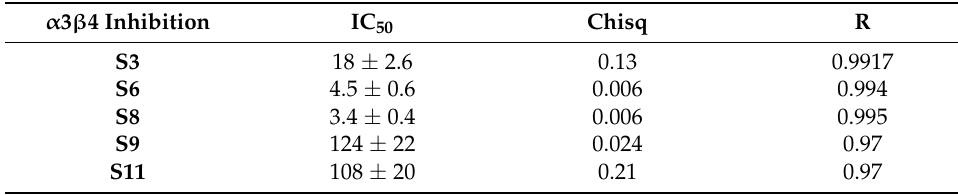
Figure 7. Inhibition of heteromeric nAChR by sulfonium compounds. ( A ) Inhibition of α 3 β 4 100 µ M ACh-evoked peak currents by the co-application of the sulfonium compounds. Data are the averaged of six to eight oocytes (±SEM). To confirm the stability of the ACh responses, applications of ACh plus the sulfonium compounds were alternated with applications of ACh alone. Curve-fit values are provided in Table 3. ( B ) Inhibition of ACh control peak-current responses of α 4-containing nAChR formed with concatamers by 100 µM of the sulfonium compounds indicated. Data are the average of six to eight oocytes (±SEM). Table 3. Parameters extracted from curve fits for Figure 7A.